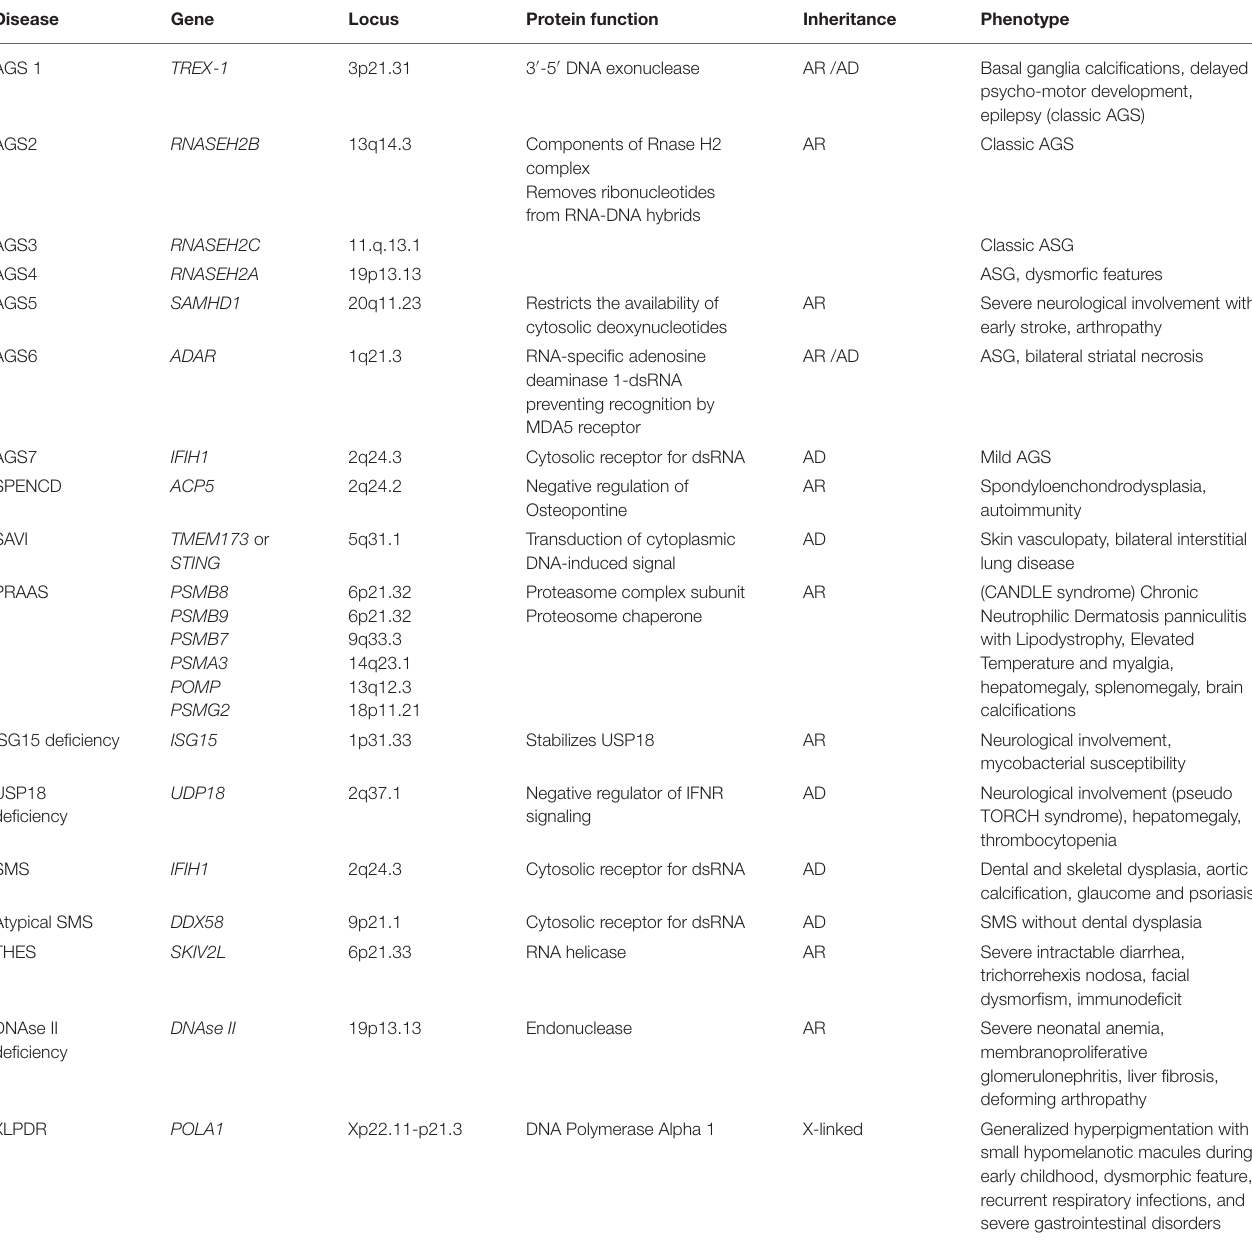
TABLE 1 | Mutated gene and corresponding locus, protein function, pattern of inheritance, and common symptoms of main type I interferonopathies.